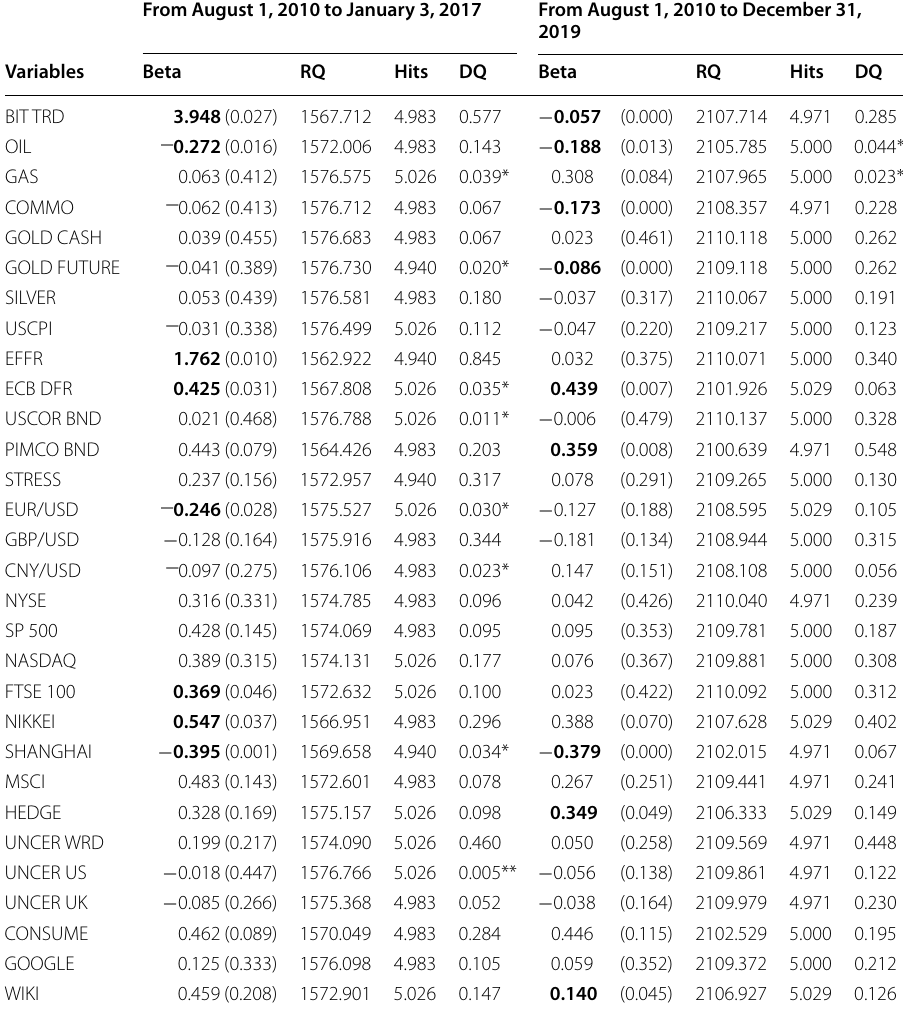
Table 4 Estimation results of the 5% CAViaRs with explanatory variables adopting